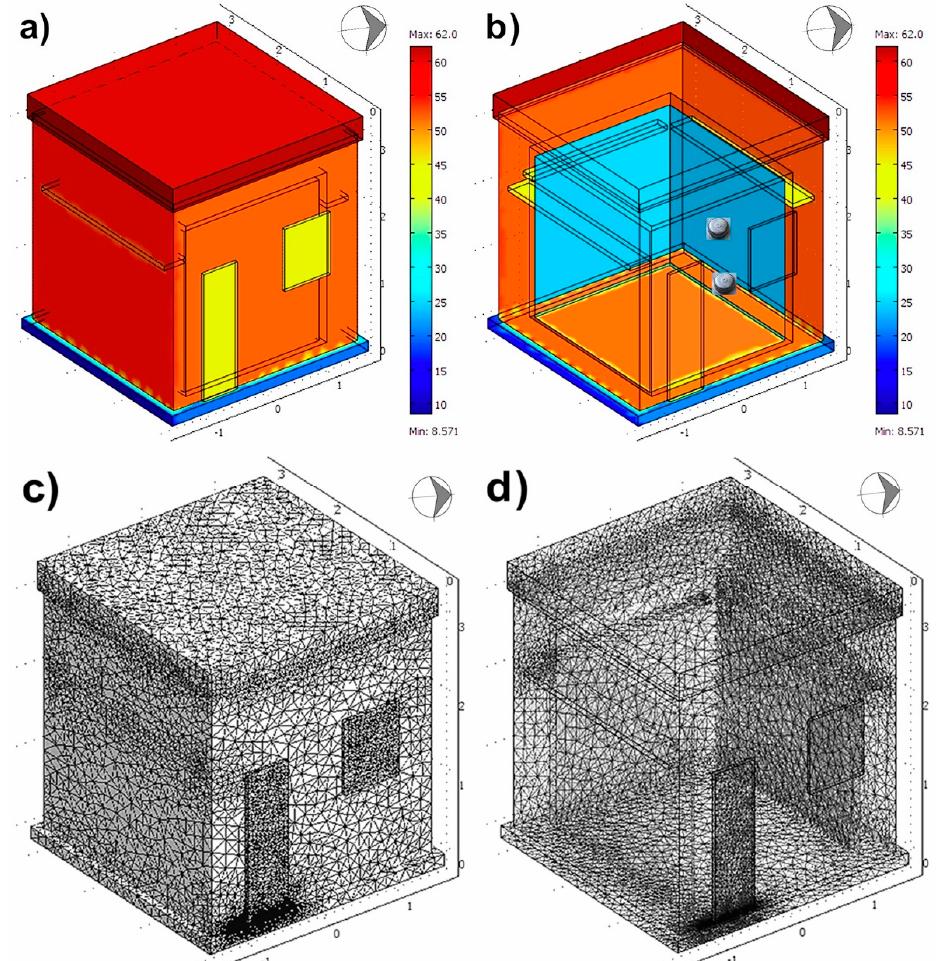
Figure 6. The images of thermal transference simulation of the PET prototype. Thermal distribution in ( a ) outer view and ( b ) inner view, with bar scale at right. Polygonal net at ( c ) outer view and ( d ) inner view.